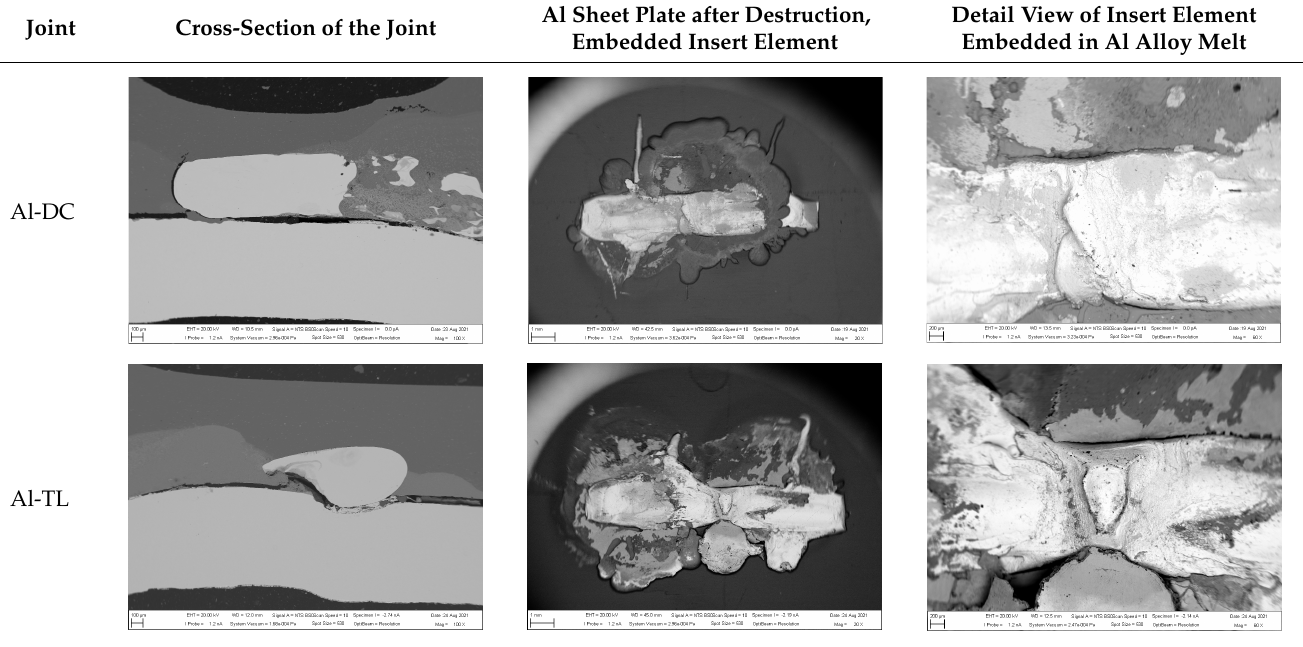
Figure 20. SEM analysis of Al-DC connection, distribution element maps and EDX spectra.